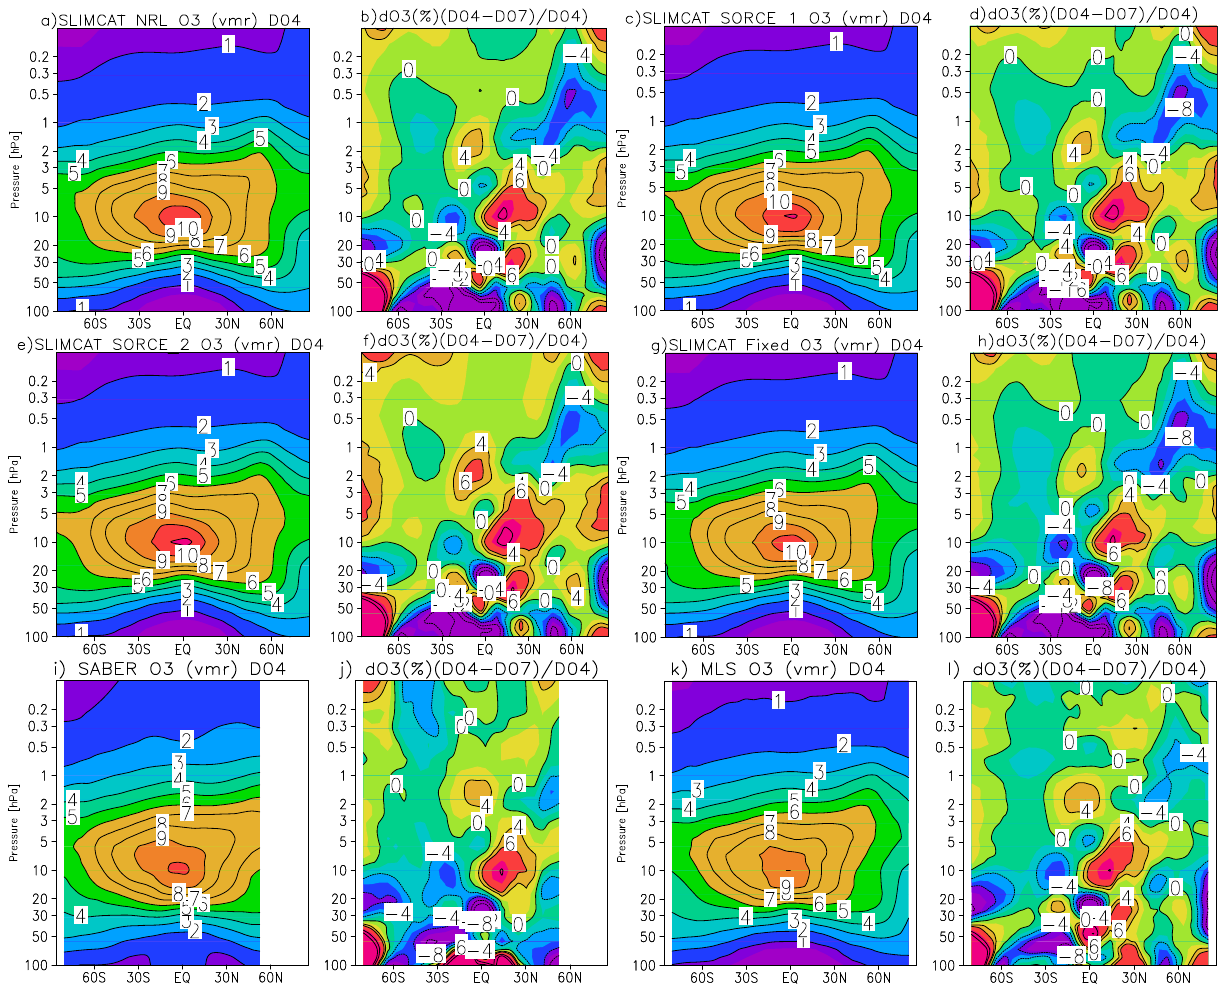
Fig. 4. Zonal mean monthly mean O 3 mixing ratio (ppmv) from SLIMCAT runs A_NRL , D_SORCE2004_1 , F_SORCE2004_1 , C_FIX ( a , c , e and g ) and SABER and MLS ( i and k ) for December 2004. The ozone differences (%) between December 2004 and December 2007 for the corresponding data sets are also shown ( b , d , f , h , j , l